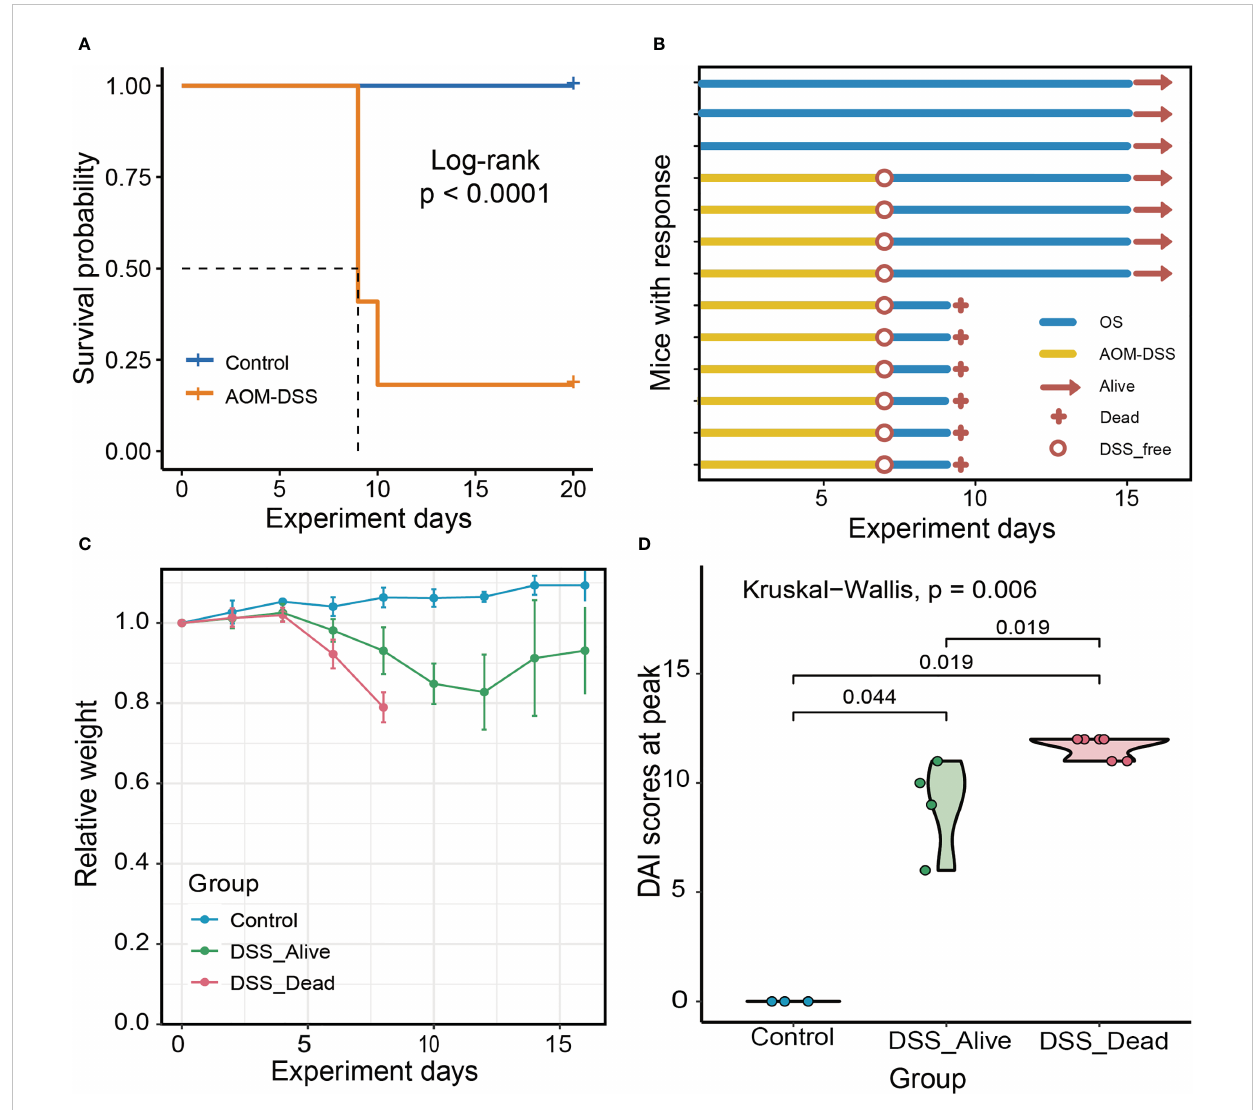
FIGURE 1 Experiment overview and mice characteristics of the three group. (A) Survival plot of AOM-DSS treated mice and control. (B) Experimental protocols, progress and results for Control group, DSS_Alive group and DSS_Dead group. (C) Changes in body weight of the three group as the experiment was conducted over time. (D) Violin plot of the highest DAI score of the three group. Kruskal-Wallis test was used to tested the differences of the DAI scores at peak in three